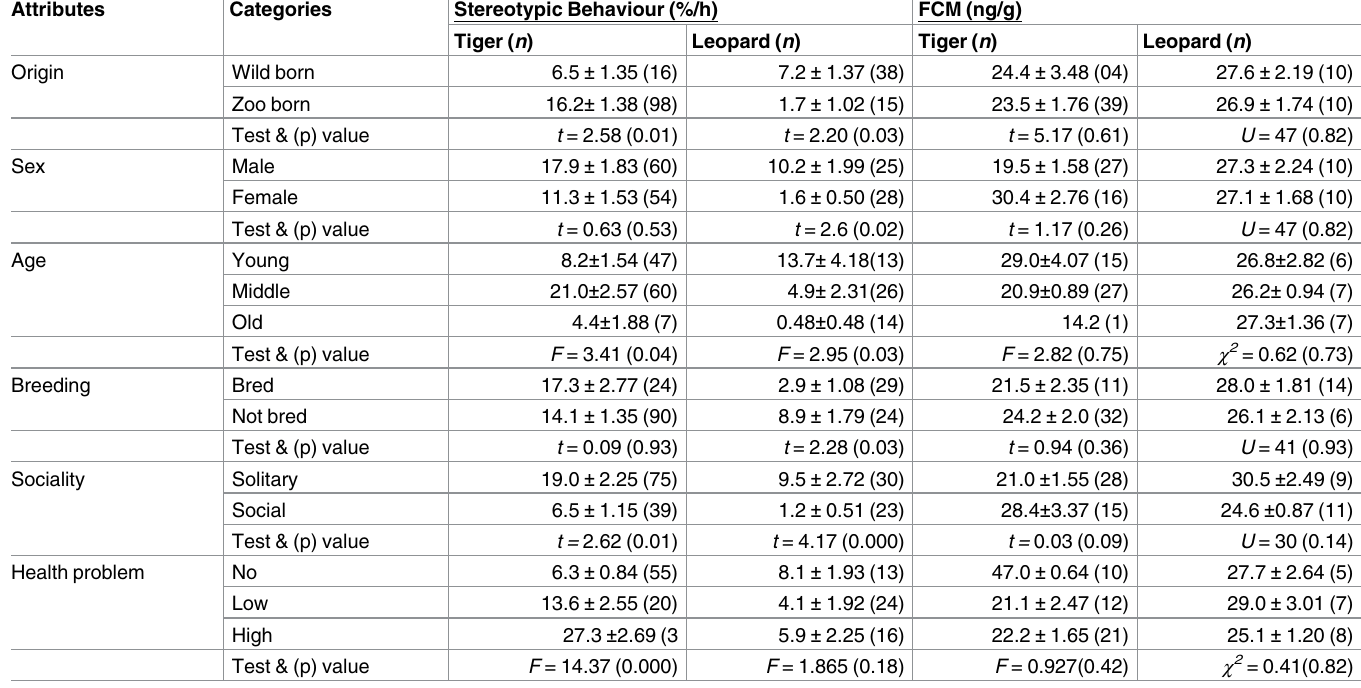
Table 2. Extent of stereotypic behaviour and FCM ( ± SE) in relation to biological factors in tigers ( n = 41) and leopards ( n = 21). Note: F indicatesUni- variate Analysis of Variance; t indicatesindependent-samples T test, U indicatesMann-Whitney U test and χ 2 = Kruskal-Wallis test.